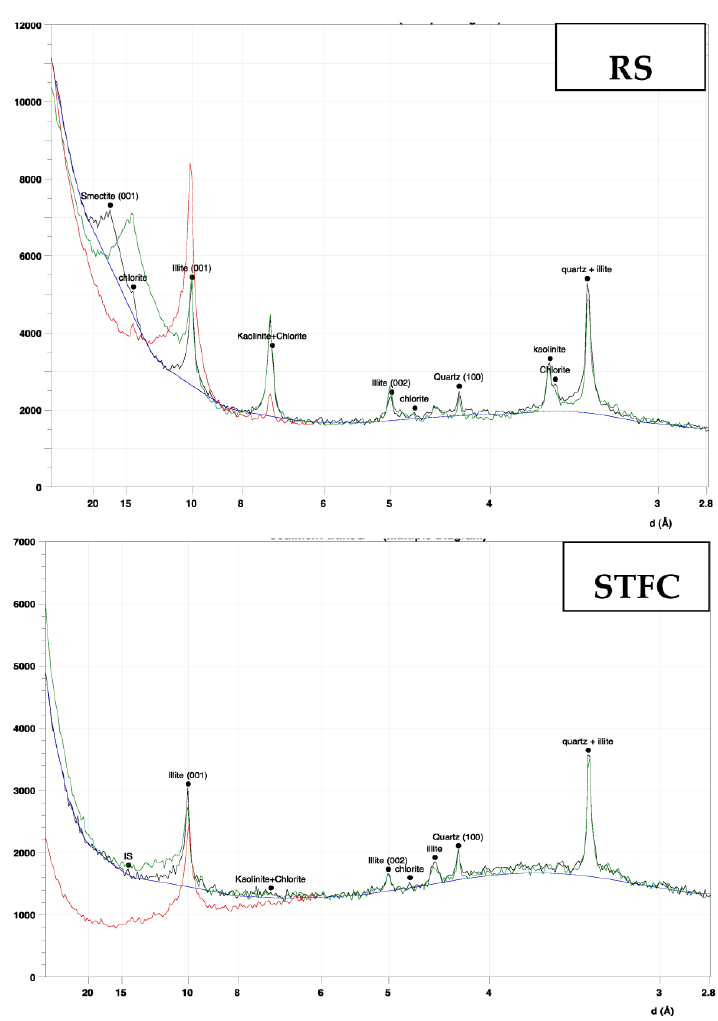
Figure 7. Identification of the mineral clay phases in RS and STFC by XRD. Table 5. Identification of clay minerals by the XRD method.